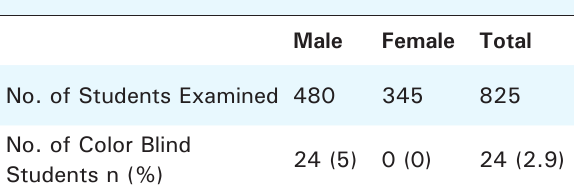
Table 2. Prevalence rate of color blindness.